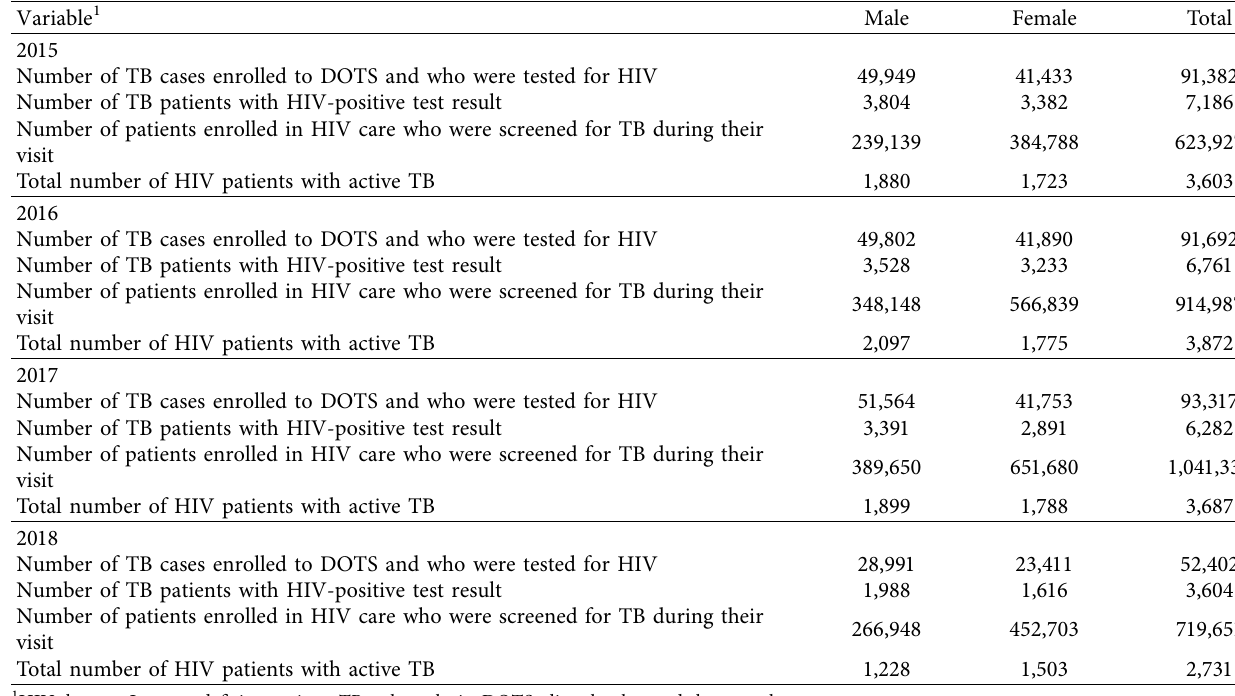
Table 1: Te number of TB, HIV, and TB/HIV coinfected patients reported in Ethiopia by gender and year. Variable 1 Male